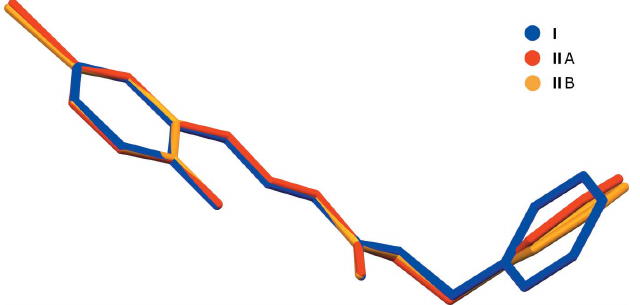
Figure 3 A least-squares fit overlay of I , II A , and II B showing the similarity of their conformations. That of I (blue) differs primarily in the orientation of the benzyl group (right). Diagram generated using Mercury (Macrae et al. , 2020).